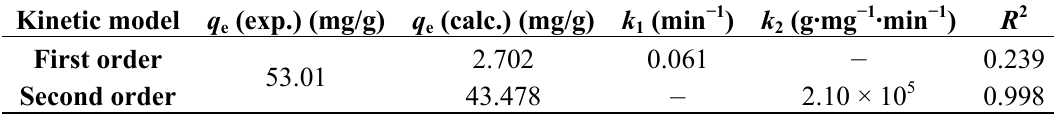
Table 2. Pseudo first order and pseudo second order sorption rate constant for melamine